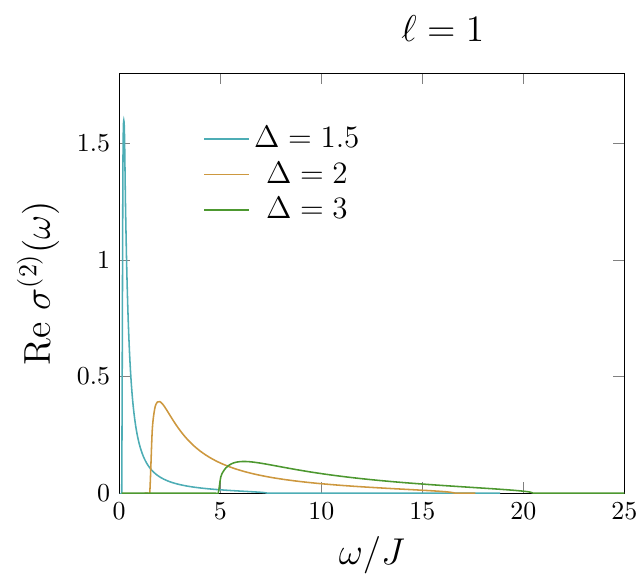
Figure 4: Comparison of the analytic result (31) and a numerical Fourier transfor- mation of the (cid:96) = 1 part of 0 ≤ m ≤ 399 and 0 ≤ tJ ≤ 50.